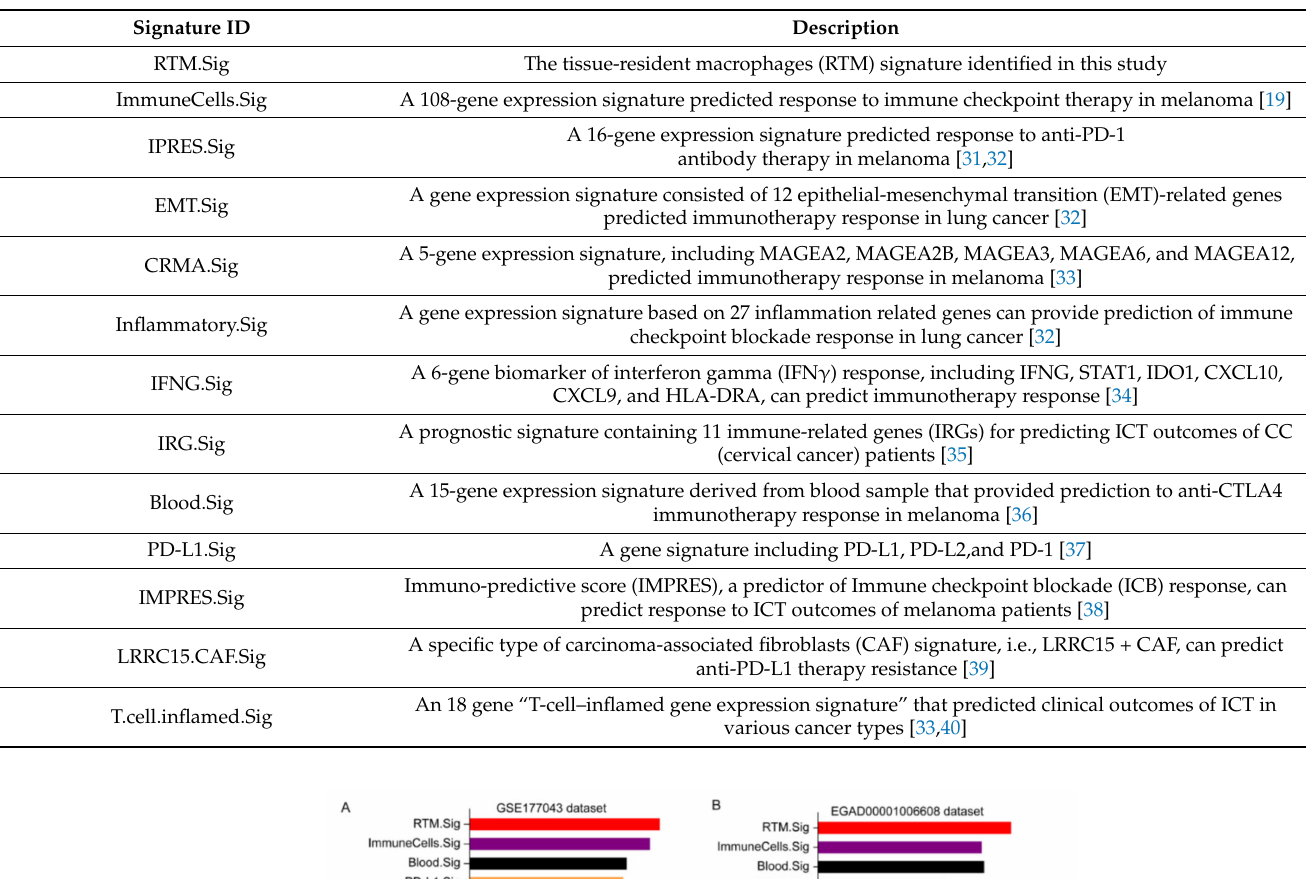
Table 1. The list of biomarkers for predicting response to immune checkpoint therapy compared in this study.